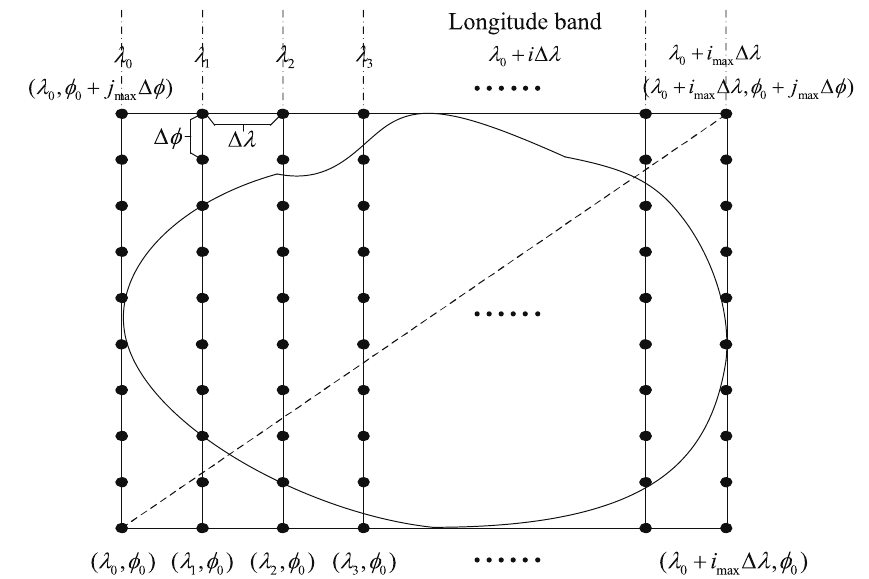
Figure 1: Schematic of a mathematical description of the target